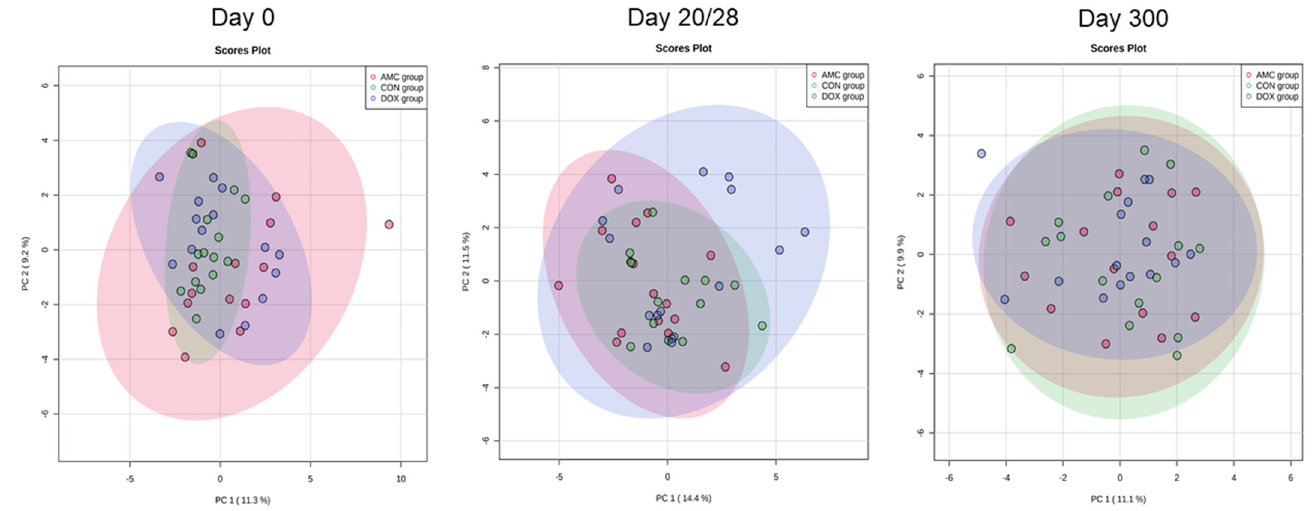
Figure 1. Principal coordinate analysis of serum metabolites on day 0 (before antibiotic administra- tion), day 20/28 (last day of antibiotic treatment for the AMC and DOX groups, respectively), and day 300 for cats in the AMC, CON, and DOX groups. Table 2. Peak heights of serum metabolites that differed significantly over time within CON